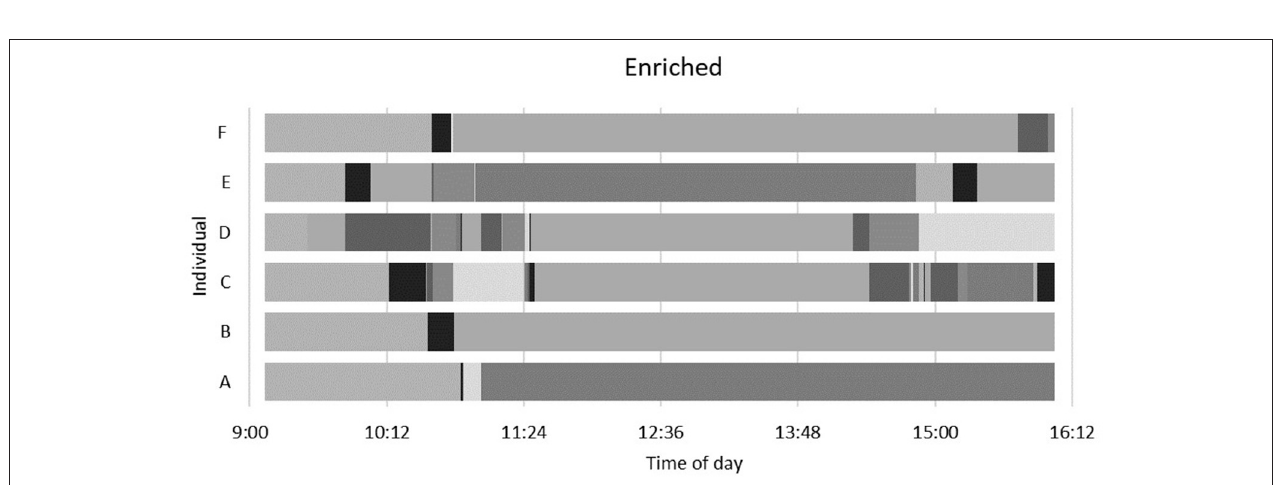
FIGURE 6 | Tracks per individual in the barren environment including false positive tracks corresponding to the time of day.